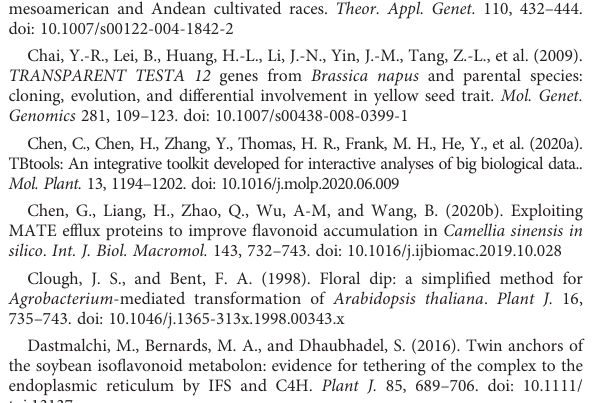
SUPPLEMENTARY FIGURE 1 Chromatogram of synthesized Epicatechin 3`-O-glucoside (red) from standard Epicatechin (blue). UV Spectrum (absorbance at 224 nM) is shown on the inset. SUPPLEMENTARY FIGURE 2 Protein sequence alignment of two PvMATE pairs between G19833 and pinto UI111- Phvul.004G152301 and PvUI111.04G149500 (A) , Phvul.004G152601 and PvUI111.04G149700 (B). Alignment coverage of Phvul.004G152301 and Phvul.004G152601 with the C- terminal halves pinto UI111 targets indicates a possible error in the sequence assembly. SUPPLEMENTARY FIGURE 3 Genomic distribution of PvMATE genes in P. vulgaris cultivar pinto UI111 chromosomes. The chromosome numbers are indicated above each chromosome and drawn to scale in megabase pairs (Mbp). The chromosome size is indicated by its relative length using the information from Phytozome 13. SUPPLEMENTARY FIGURE 4 Logo representation of the conserved motifs in PvMATEs shown in . The X-axis indicates the translated sequence length in amino acids, Y-axis indicates the bit score. SUPPLEMENTARY FIGURE 5 Subcellular localization of 4 selected PvMATE candidates. Each PvMATE was translationally fused upstream of the YFP reporter gene, co- transformed with respective organelle localization markers (vacuole and ER)-fused CFP into N. benthamiana via A. tumefacians , and visualized in leaf epithelial cells by confocal microscopy. Merged signals were collected by sequential scanning of YFP and CFP channels. Scale: 30 µm. SUPPLEMENTARY FIGURE 6 DMACA stained seeds in 8 individual T2 lines overexpressed with PvMATE1, PvMATE7 and PvMATE8. The picture was taken in normal light after 36 h of